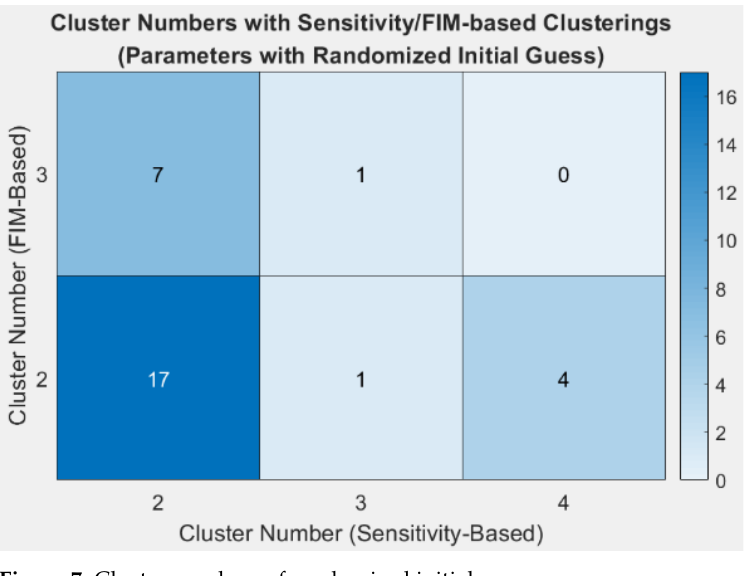
Figure 7. Cluster numbers of randomised initial guesses.